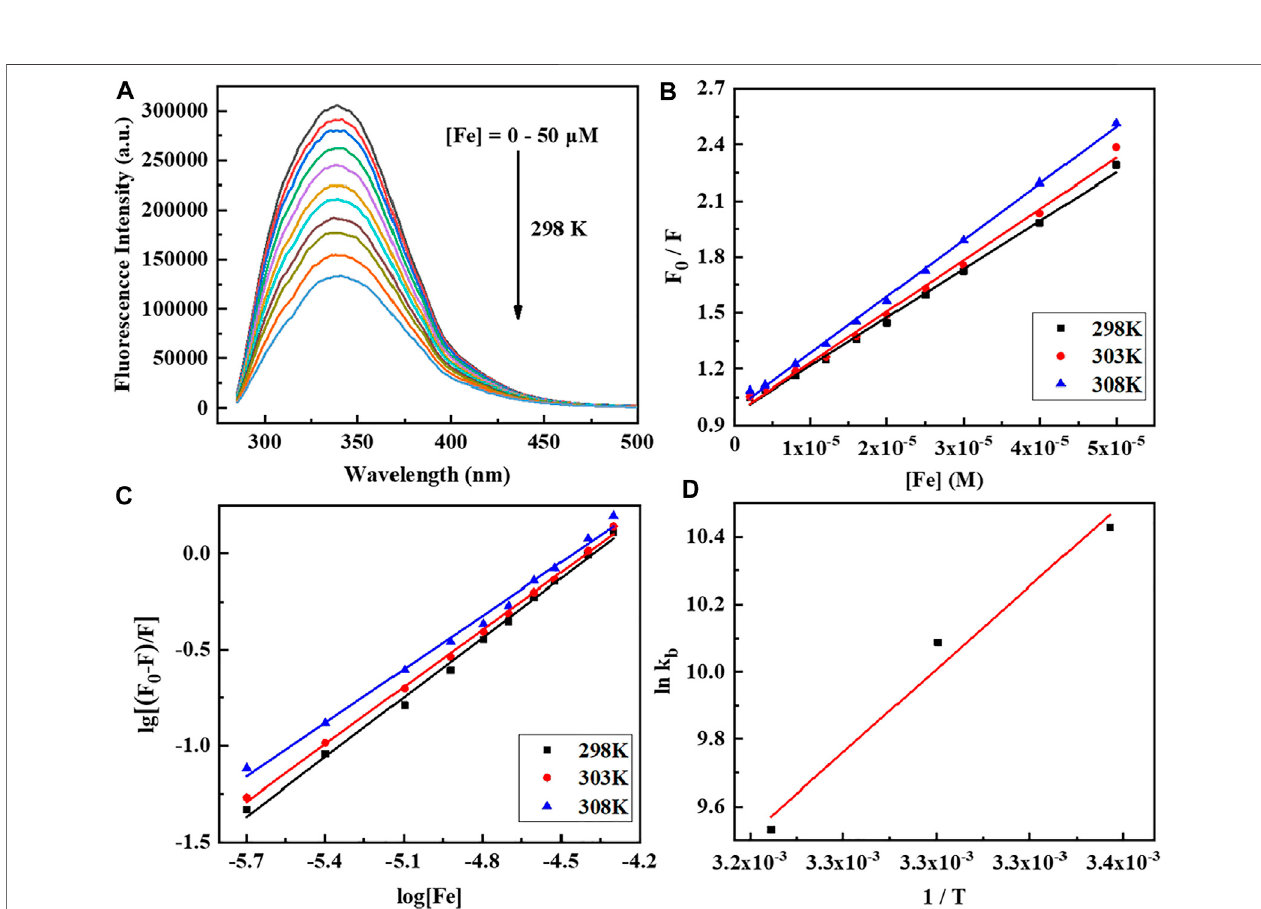
FIGURE 3 | (A) Fluorescence emission spectra of human serum albumin (HSA) (10 μ M) titration with the Fe complex by increasing concentrations (0 – 50 μ M). The excitationwavelengthis280 nm at pH 7.5and 303 K. (B,C) Stern – Volmer plotofHSA quenchedby theFecomplexat different temperatures. (D) Van ’ tHoffplot ofln K b vs. 1/T for the interaction of the Fe complex with HSA.